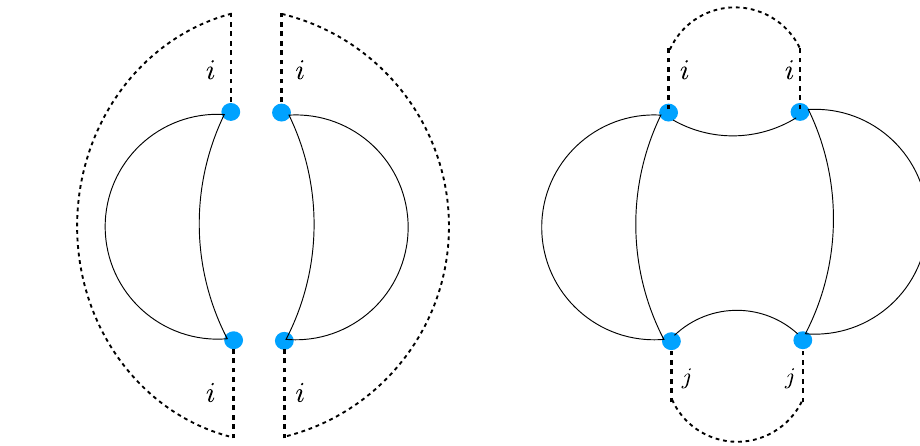
Fig. 8 To calculate purity by setting n = 2 (63), two candidate geometries are shown. On the left, for the disconnected geometry the EOW-brane index i is enforced on all dashed lines, which yields a single power of k , upon summation. On the right, for the connected/Wormhole geometry, two different EOW-brane indices can be assigned, which yields a factor of k 2 upon